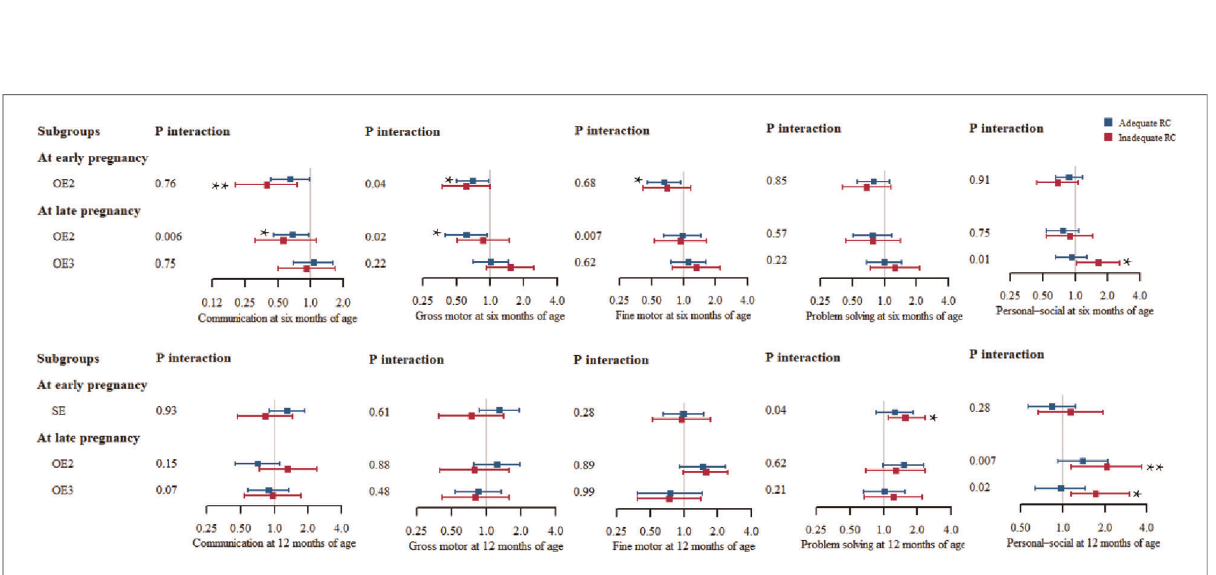
FIGURE 2 Forest plot of OR with 95% CIs of suspected developmental delay of infants grouped by maternal psychological stress and strati fi ed by responsive caregiving (model III). The participants in low stress level group were used as a reference. All of the models adjusted for maternal age at delivery, education level, household income, gestational weeks at birth, birth weight, and main caregivers at 2 months of age. * P <0.05; ** P <0.01. SE, subjective events; OE2, general negative objective events; OE3, severe negative objective events; RC, responsive